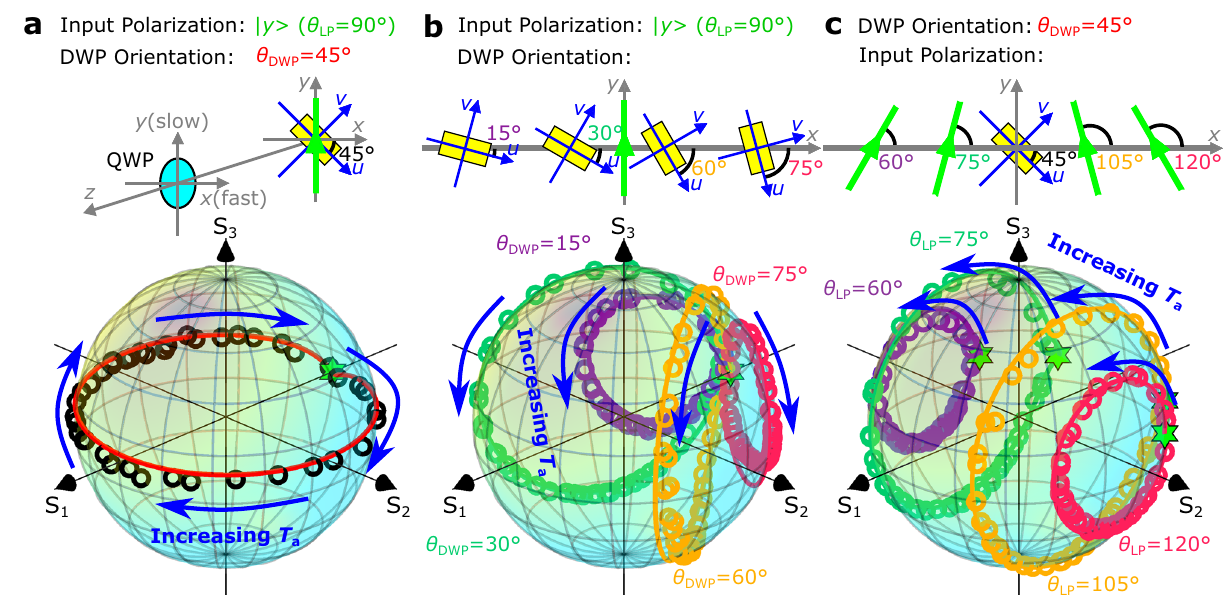
Fig. 4 Versatile polarization transformations. a – c Calculated (lines) and measured (circles) polarization trajectories on the Poincaré sphere realized at the wavelength of 800 nm by tuning the air gap T a for different dynamic wave plate (DWP) orientations, illustrating the diversity of possible polarization transformations: a continuous linear polarization (LP) rotation realized by combining the DWP with a conventional quarter-wave plate (QWP) with the incident LP state | y > and DWP orientation θ DWP = 45°, b various elliptical polarization transformations realized for different DWP orientations with the fi xed incident LP state | y >, and c various elliptical polarization transformations realized for different incident LP states with the fi xed DWP orientation θ = 45°. The green stars in ( a – c ) indicate respective incident LP DWP